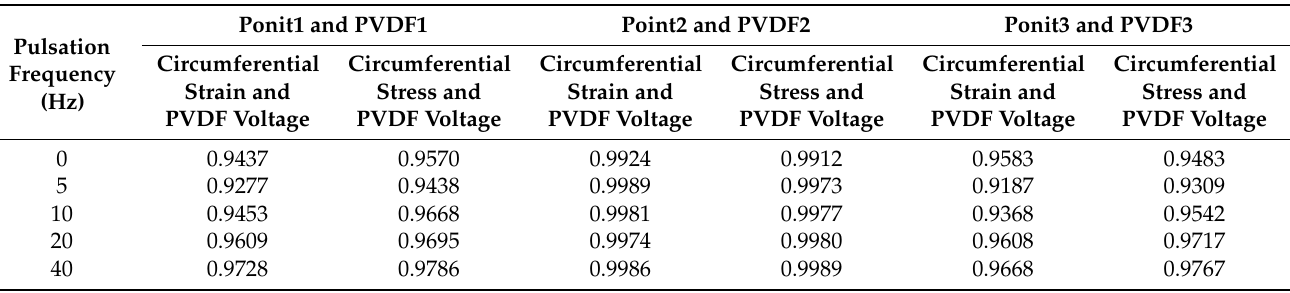
Table 4. Correlation coefficient.